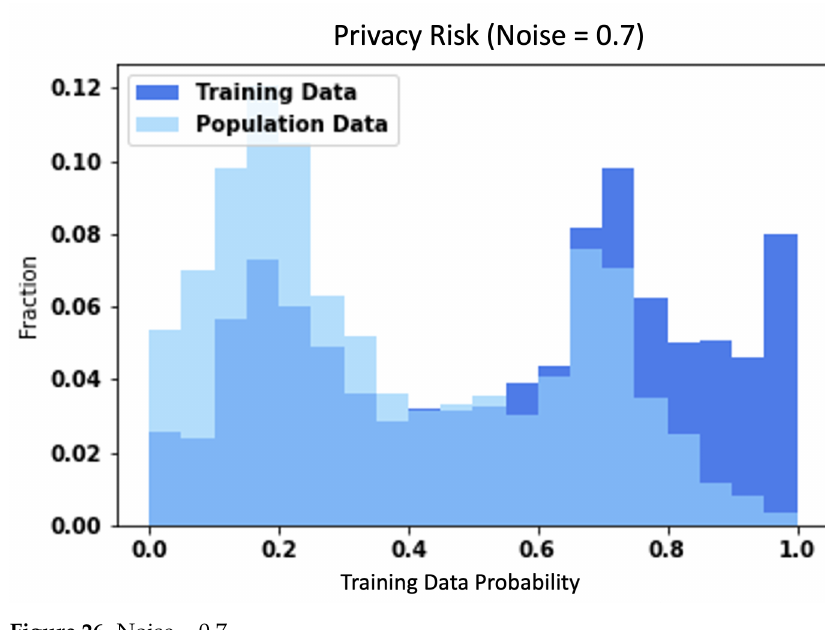
Figure 26. Noise = 0.7.